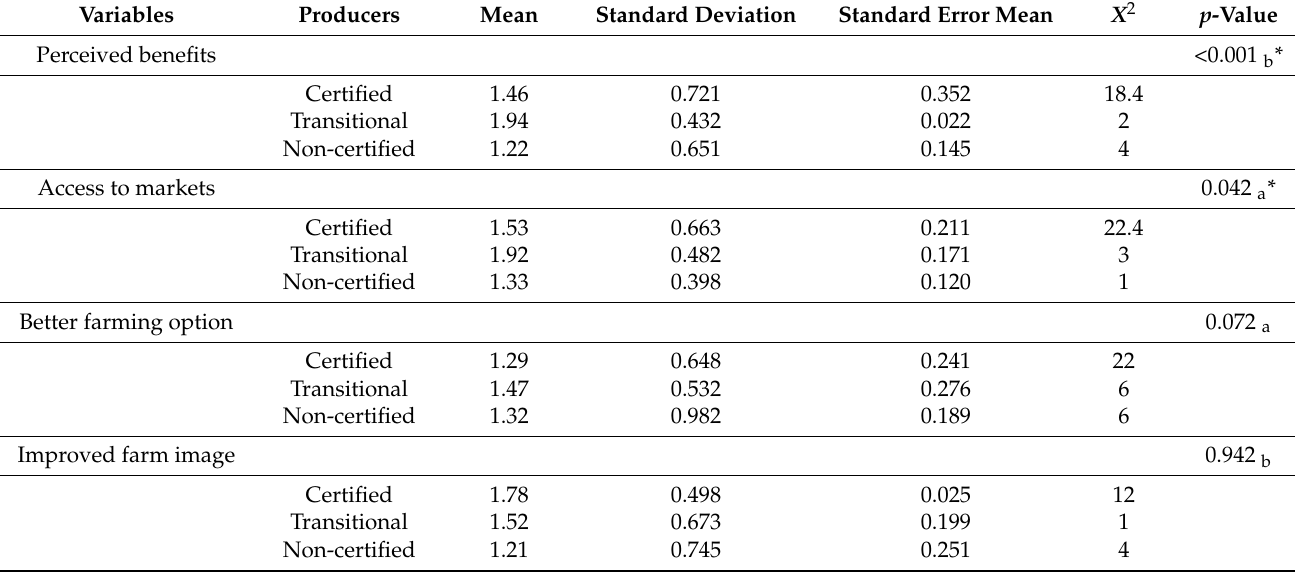
Table 3. Descriptive statistics of farmers’ perceptions towards organic